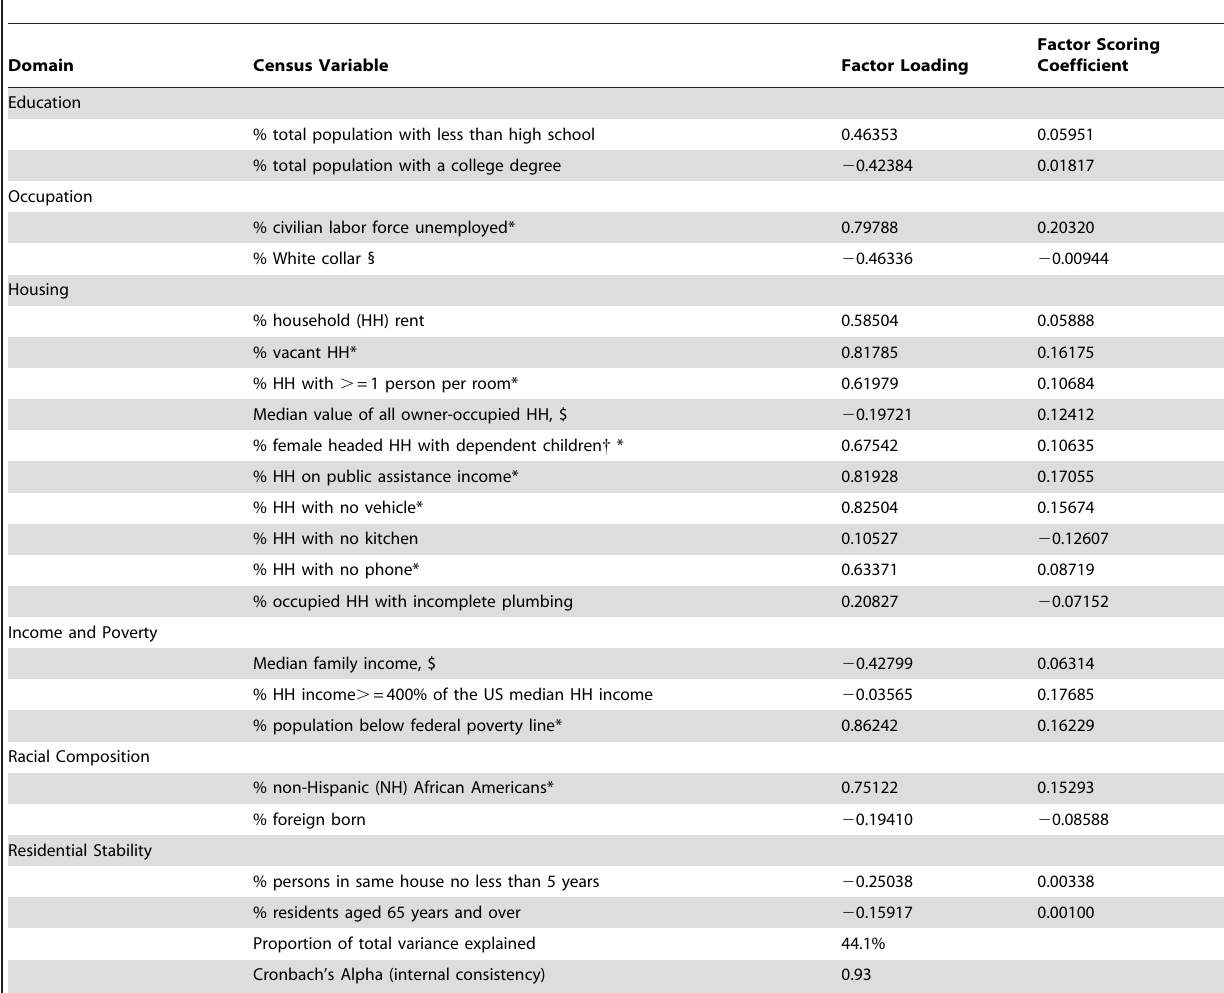
Table 1. Characteristics of Census variables composing census block group socioeconomic (SES) deprivation